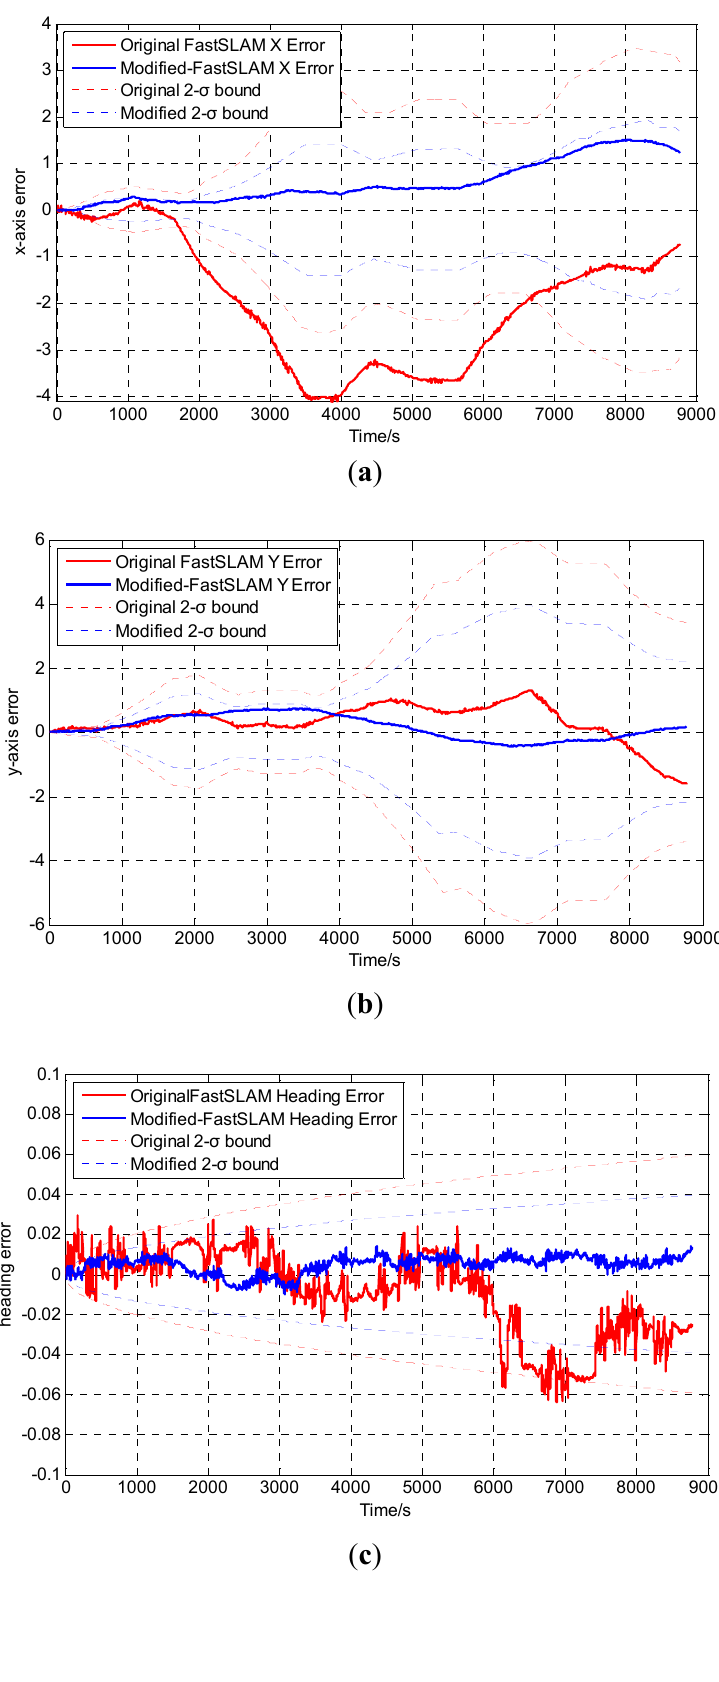
Figure 7. Estimation pose error with 2- σ uncertainty bound of the original FastSLAM and the modified FastSLAM